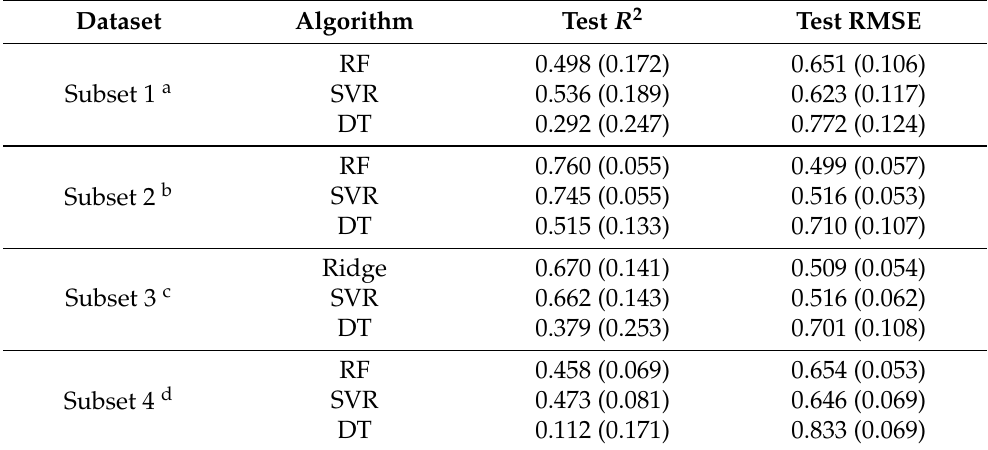
Table 2. Mean performance of best two performing and baseline models on predicting the pChEMBL value, evaluated by the coefficient of determination ( R 2 ) and root mean square error